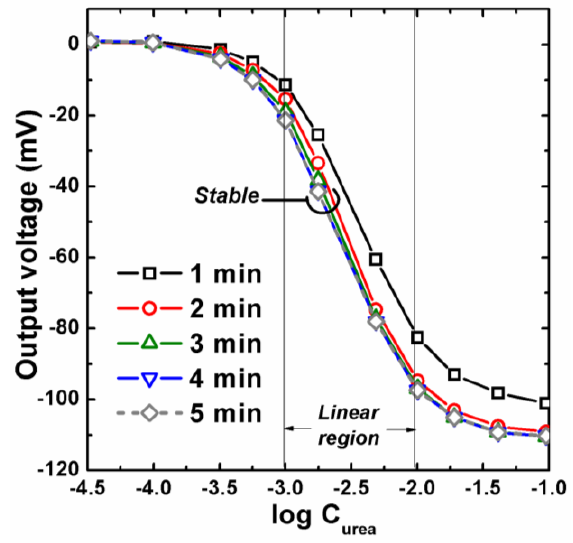
N , Ta O , and annealed Ta 3 4 2 5